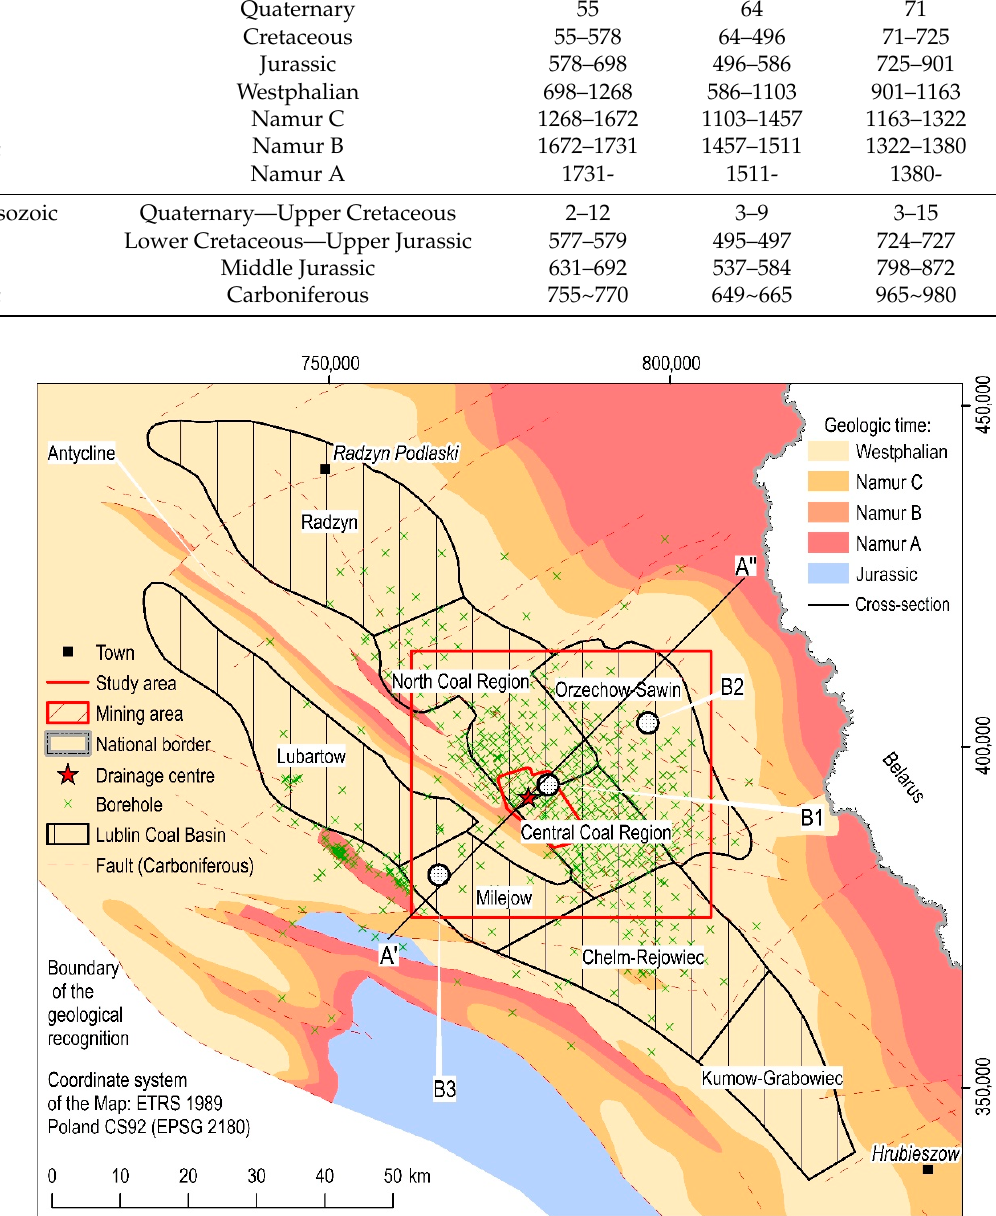
Figure 2. The location of the Lublin Coal Basin and the Central Coal Region of Poland in the area of interest; the geological and tectonic conditions of the study area without Quaternary and Cretaceous deposits on a cutting plane of 750 mbsl (meters below surface level) and the spatial distribution of boreholes. Table 1 displays data on the stratigraphy and depth of geological strata and aquifers in selected boreholes B1, B2 and B3. Source of data: the Polish Geological Institute-National Research Institute.